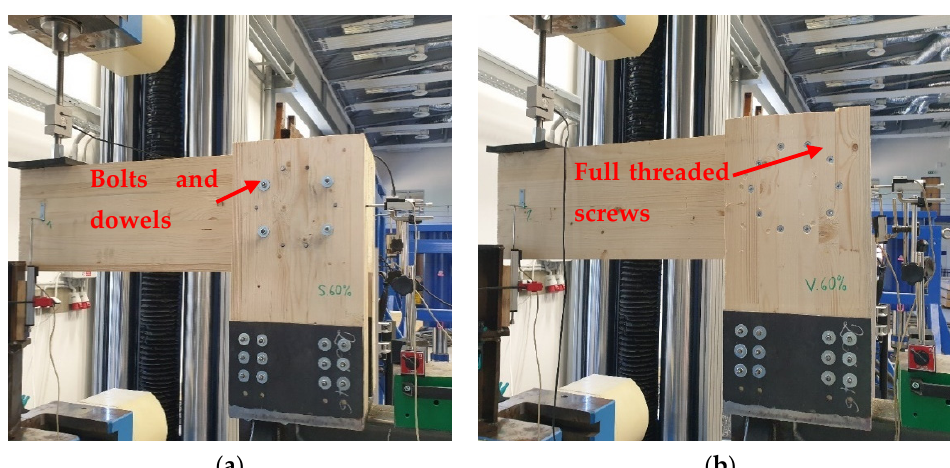
Figure 9. Experimental specimens: ( a ) Experiment A, bolts and dowels; ( b ) Experiment B, fully threaded screws.